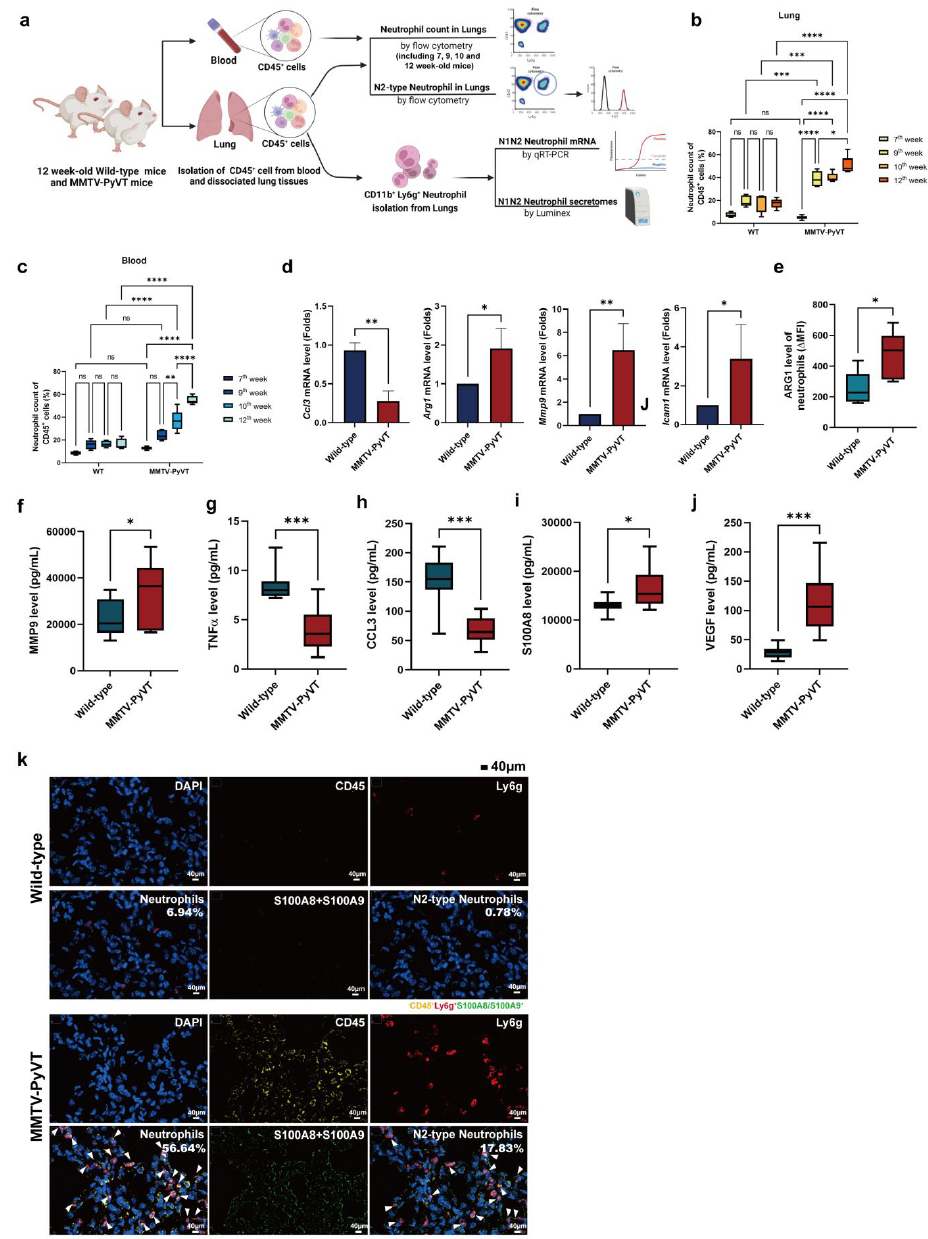
Figure 4. The infiltration and phenotypes of neutrophils in the blood and lungs of MMTV-PyVT mice. ( a ) The workflow of blood and lung neutrophil isolation. ( b ) The cell number of neutrophils in the lungs of wild-type and MMTV-PyVT mice. ( c ) The cell number of neutrophils in the blood of wild-type and MMTV-PyVT mice. ( d ) Expression of Arg1 , Icam1 , Mmp9 and Ccl3 in neutrophils, as determined by qRT-PCR. The protein levels of ( e ) ARG, ( f ) MMP9, ( g ) TNF α , ( h ) CCL3, ( i ) S100A8 and ( j ) VEGF in neutrophils of the lungs of mice ( n = 7–11). The expression of arginase I on fresh isolated neutrophils was assessed by flow cytometry. The levels of various soluble factors in the supernatant were detected by a Luminex system after 24-h culture. * p < 0.05, ** p < 0.01, *** p < 0.001, **** p < 0.0001. ( k ) N2-type neutrophils were found in the lungs of MMTV-PyVT mice. The lungs of wild-type and MMTV-PyVT mice was collected and stained by CODEX-based multiplexed tissue staining . N2-type neutrophils (CD45 + (yellow) Ly6G + (red) S100A8/A9 + (green) cells) were indicated by the white arrow. The percentage of N2-type neutrophil was indicated as a percentage of total CD45 + cells. Scale bars, 40 µ